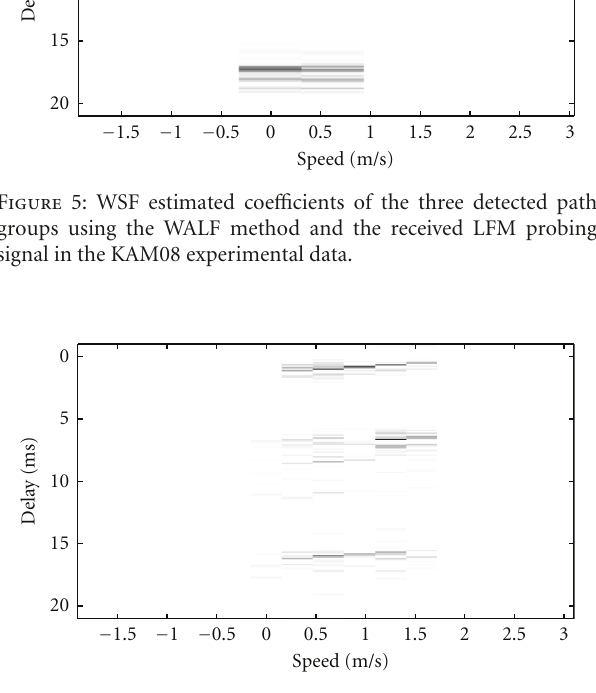
Figure 6: WSF estimated coe ffi cients using the least-squares method and the received OFDM probing signal in the KAM08 experimental